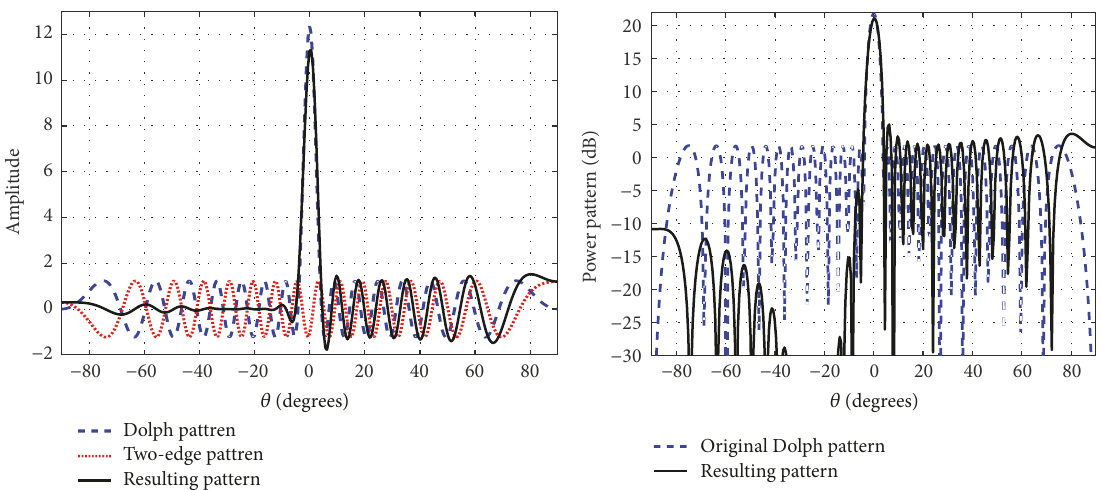
Figure 4: Radiation patterns of the original Dolph-Chebyshev array and the proposed arrays for 𝑁 = 30 , 𝑑 = 𝜆/2 , and 𝑃 = 18.7121 ∘